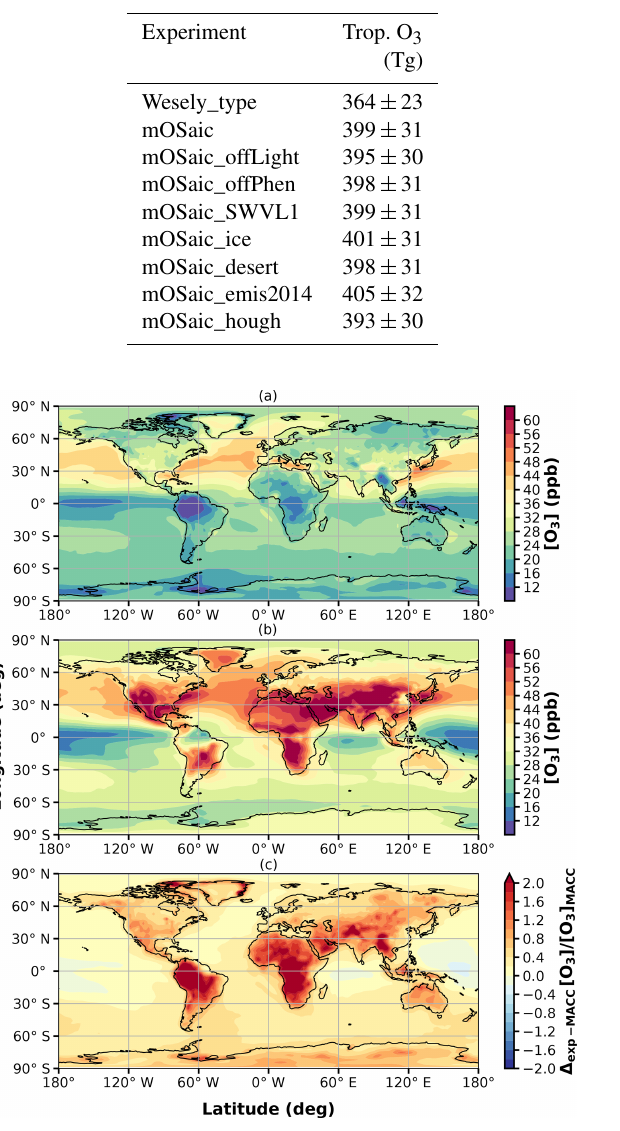
Figure 8. Mean ozone concentrations for the year 2005. (a) MACC reanalysis (surface); (b) Oslo CTM3 mOSaic (lowermost model level); (c) relative